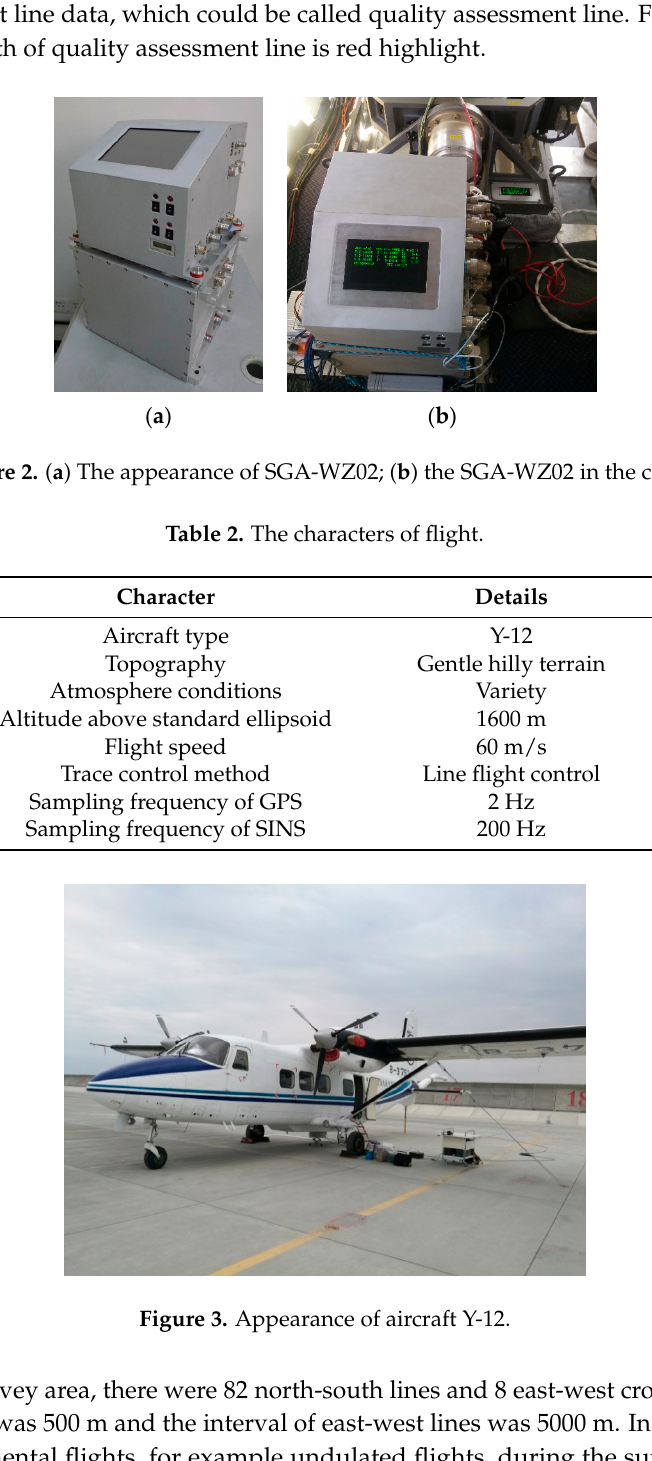
Figure 4. Path of certain flight. To cover the survey area, there were 82 north-south lines and 8 east-west cross lines. The interval of north-south lines was 500 m and the interval of east-west lines was 5000 m. In addition, there were also several experimental flights, for example undulated flights, during the survey. So, this survey totally contained 21 separate flights. Based on the cross-point internal quality assessment, the total accuracy of this survey was 2.09 mGal in the resolution of 4.8 km. After cross-point adjustment, the accuracy could reach 1.30 mGal. Figure 5 shows the gravity disturbance and cross-point differences in the survey area after adjustment. The use of cross point internal RMSE could evaluate the truly accuracy of system and the total survey quality. However, as mentioned, cross point internal RMSE needs extra flight and more extra flights mean more comprehensive evaluation. When the cross points are not available, how to assess the single line quality should be considered, which means the quality assessment method is quite needed. Let assume that such a situation, the survey lines were added outside the arranged area where cross-over points were unavailable. Under above conditions, the single line quality assessment method is the proper way to assess the new lines’ quality. In addition, single line quality assessment method is also helpful in the airborne gravimetry quality control. In the next section, the relationships between quality assessment determinants and internal RMSE in this regional airborne gravimetry task were given by linear fitting. The single line quality assessment model for SGA-WZ02 was built by weighted linear fitting results. What needs to be noted is that the model was specially established for SGA-WZ02 while the method could be also generalized to other strapdown gravimeter.